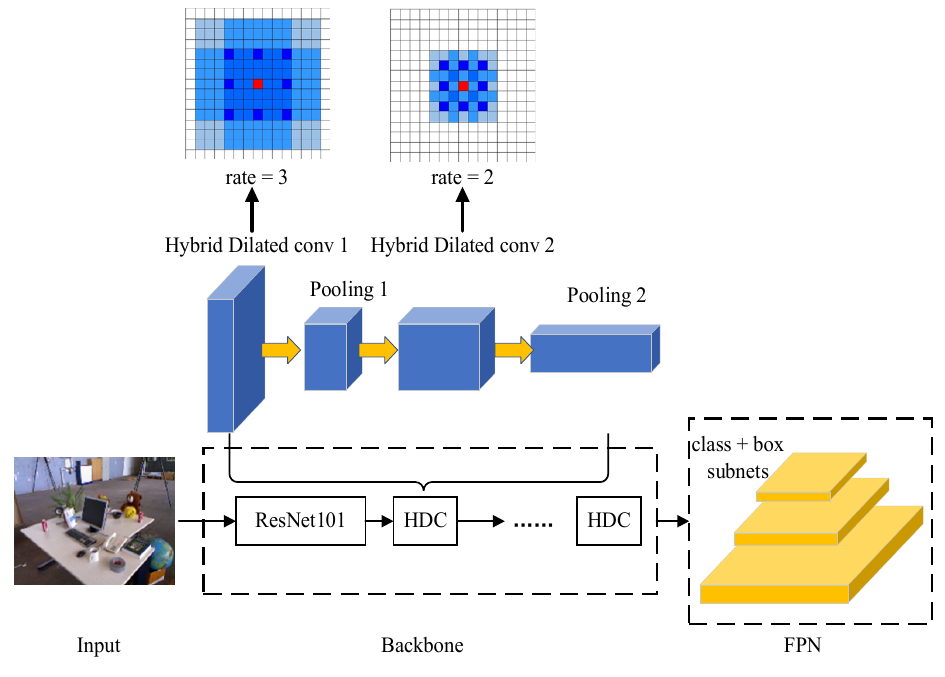
Figure 4. The diagram of backbone detector based on hybrid dilated convolutional neural network.